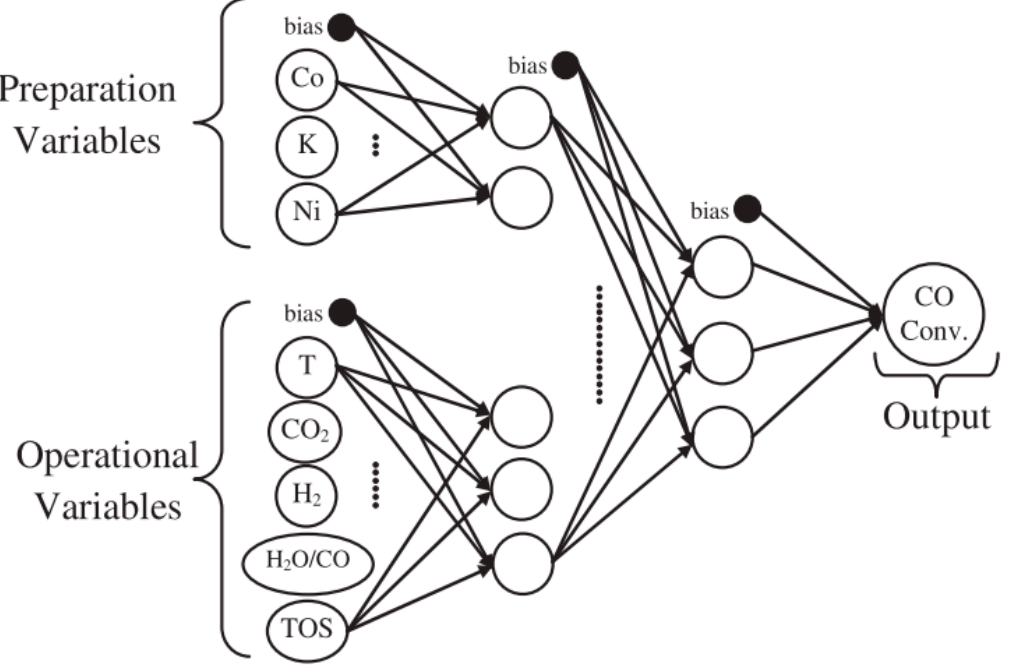
Figure 8. Topology of the optimum neural network model, reproduced from [61], with permission from Elsevier, 2017.